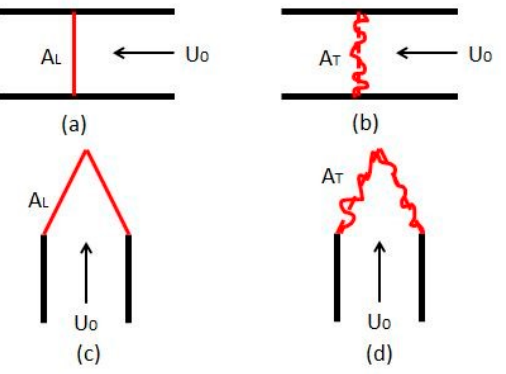
Figure 2. Flame front surface of ( a , c ) laminar premixed flame and ( b , d ) turbulent premixed flame. The premixed turbulent jet flames have low turbulent intensity, and they are wrinkled flames and corrugated flames, which were generated with different Reynolds number by a flat flame burner which contains a center jet tube. The single shot of the OH-PLIF image clearly presents the structure of the flame front. These images were used in the present study to calculate the turbulent flame speed of the syngas with varied compositions and turbulent intensities. The corresponding turbulent flame velocities were obtained by processing the OH-PLIF images of different syngas jet flames. The whole data process is shown in Figure 3. The color bar with the value from 0 to 2000 represents the signal intensity of the OH radical: the larger the color number, the stronger the signal intensity. All of the color bars with values in the following figures represent the signal intensity of OH radical. Figure 3a represents a typical OH-PLIF instantaneous image of a jet flame. The unburned area and the burned area can be distinguished according to the intensity of the OH fluorescence signal. During the image processing, the unburned region was assigned to 0 and the burned region was assigned to 1, as shown in Figure 3b. The flame is shown as black for the unburned region, assigned 0, white for the burned region, and assigned 1. In the present experiment, 500 instantaneous images were collected for each operation condition. The unburned area and the burned area were treated with the binary method, and 500 average images (Figure 3c) were obtained, which showed the probability distributions of the unburned and burned regions. The isolines with a value of 0.5 were extracted from Figure 3c to obtain the average flame front of the turbulent flame. The contours of isolines with a value of 0.5 and the corresponding fitting lines are shown in Figure 3d because of the symmetry of the flame. The average front surface area of turbulent flame was obtained by rotating the integral of the fitted line, and then the turbulent flame velocity was calculated by the following formula: